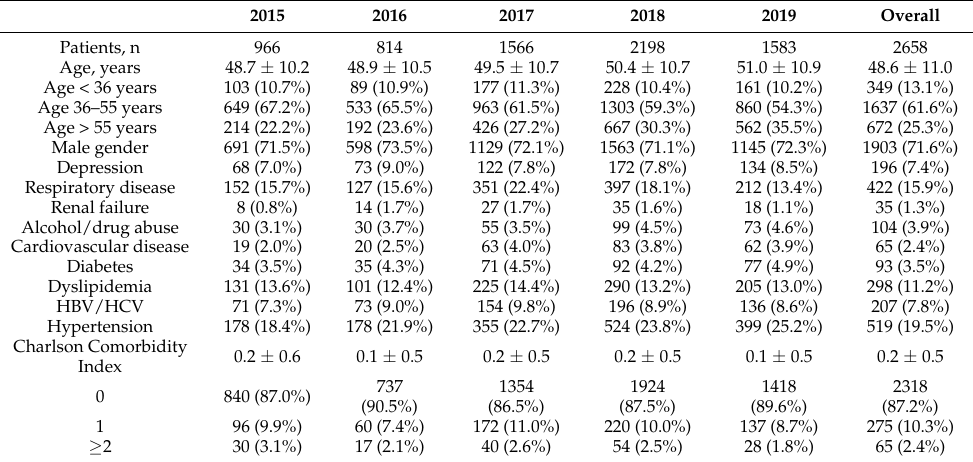
Table 1. Demographic and clinical characteristics of the overall ART-treated patients and divided by calendar year. Continuous variables are reported as mean ± standard deviation and categorical variables as numbers and percentages in